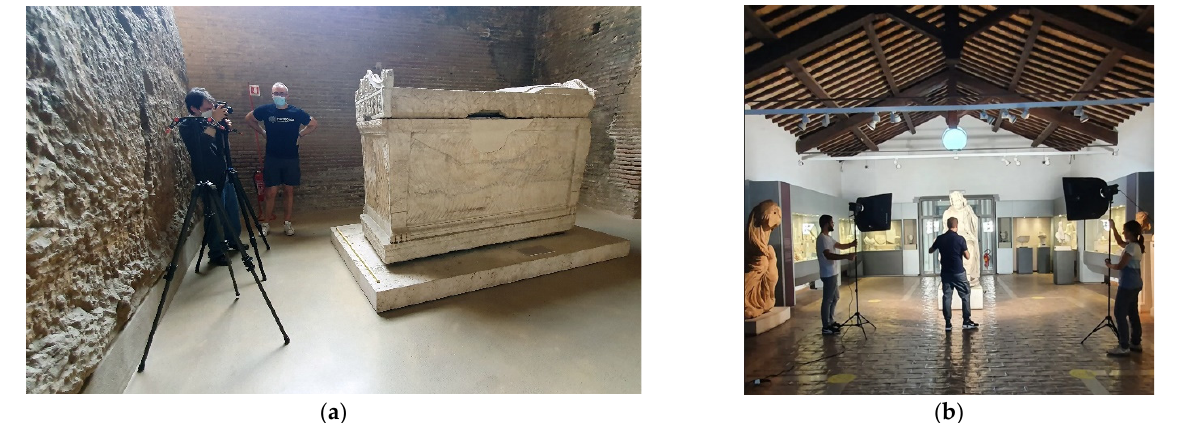
Figure 5. Photogrammetric survey operations: ( a ) Museo Nazionale Romano. Baths of Diocletian (courtesy of Ministero della Cultura—Museo Nazionale Romano), ( b ) Museum of Villa Dei Quintili.